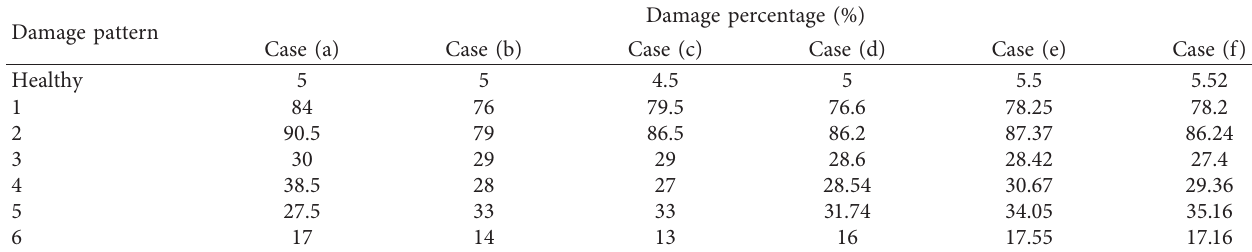
Table 2: Damage percentage in IASC-ASCE benchmark structure under different damage patterns for cases (a) to (f). Damage